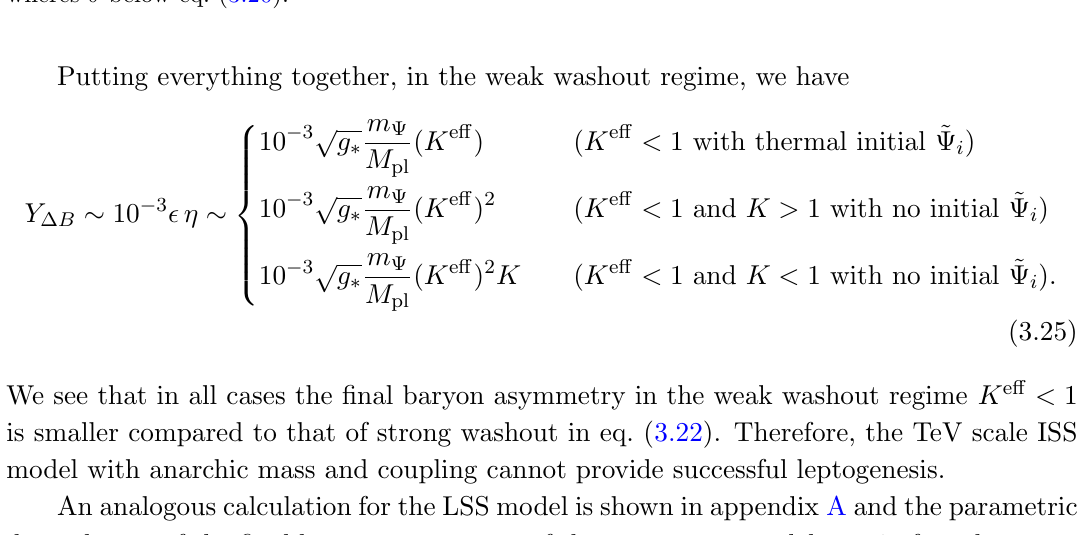
Table 2 . Summary of the parametric dependence of CP asymmetry, washout, baryon asymmetry in inverse [see eq. (3.1)] and linear seesaw [see eq. (3.2)]. The parameters "; " 0 are de(cid:12)ned in eq. (3.3), wheres (cid:14) below eq.